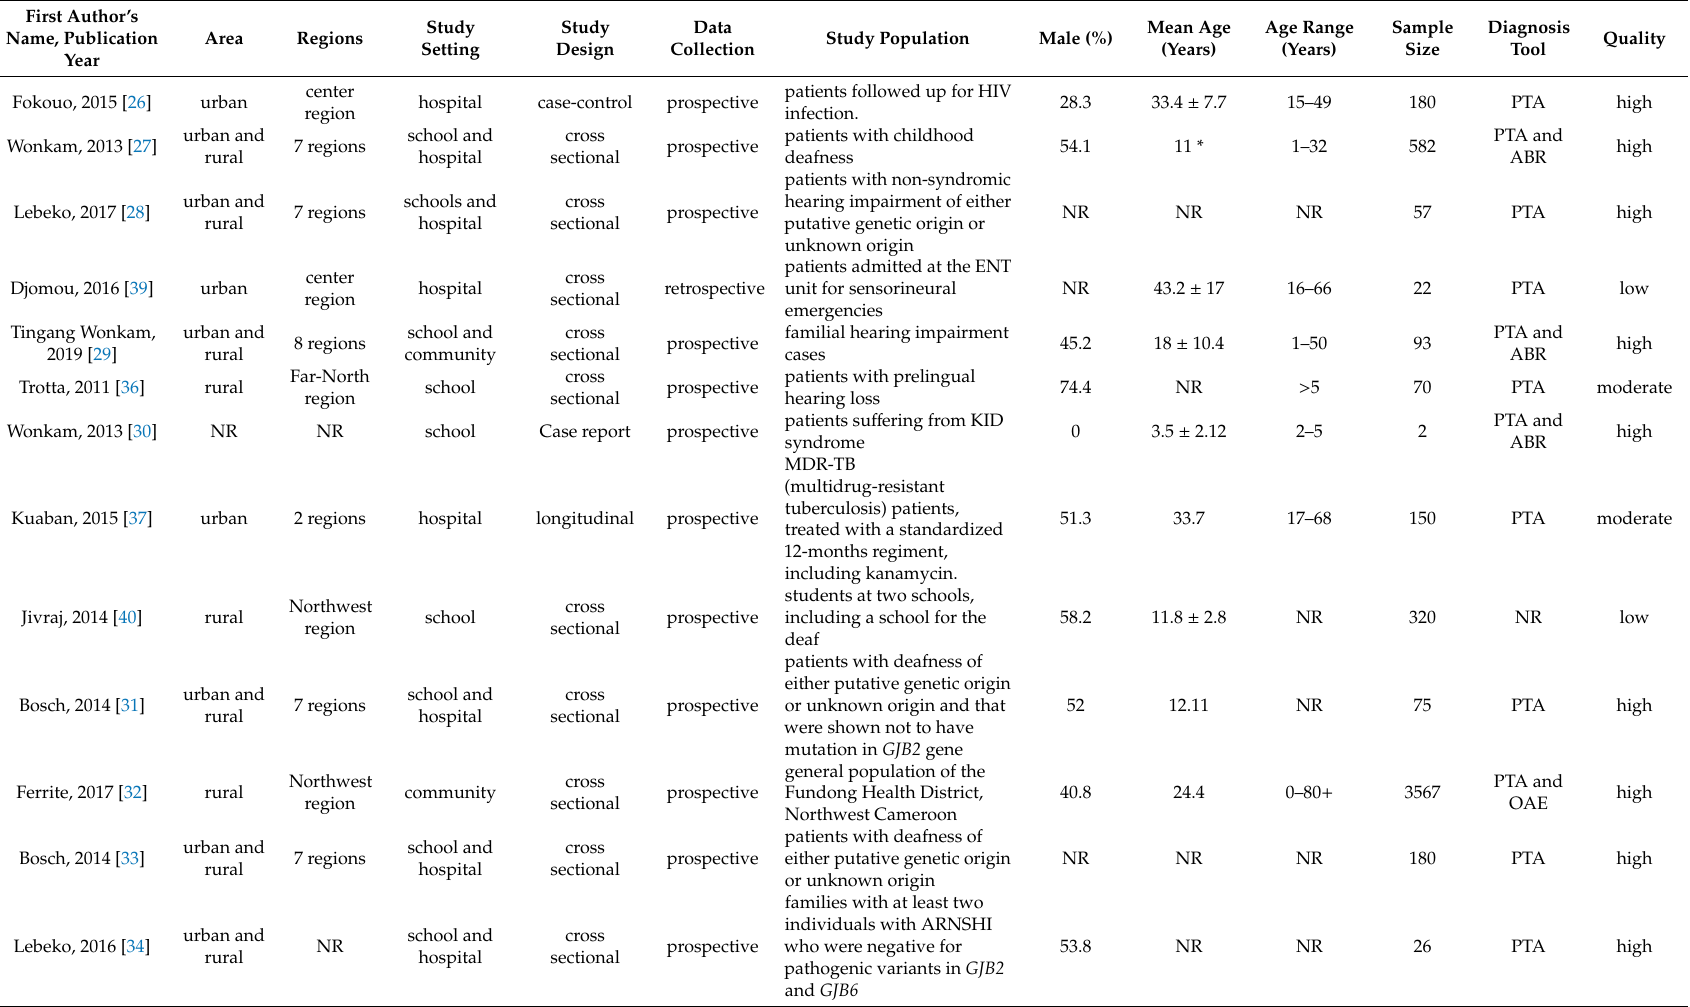
Table 1. General characteristics of the included